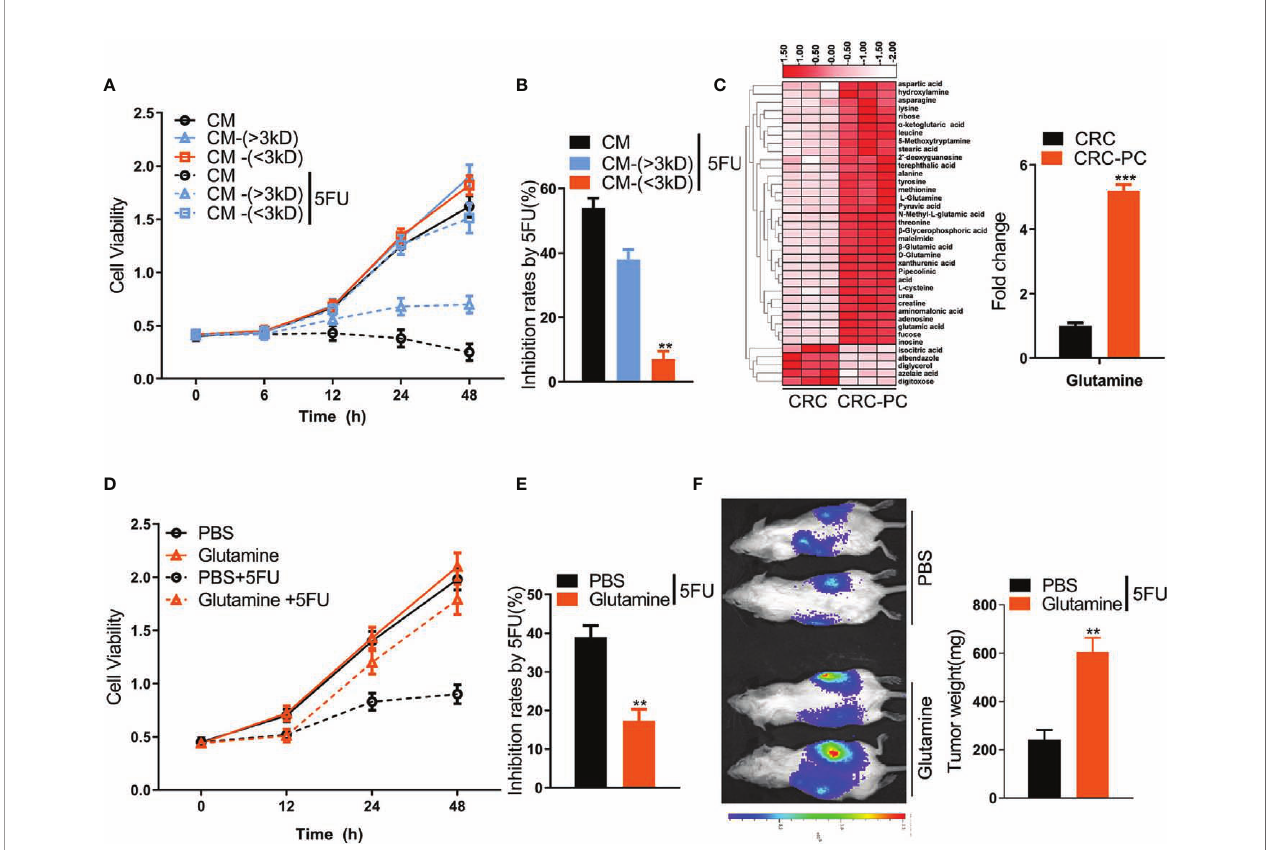
FIGURE 2 | Adipocyte-derived glutamine (Gln) promotes resistance to 5FU chemotherapy in mouse CRC cells. (A) CM was separated into two fractions based on size: CM-(<3 KD) and CM-(>3 KD). The cell viability of CT26 cells treated with CM, CM-(<3 KD) or CM-(>3 KD) plus with/without 5FU (10 m mol/L) was measured. (B) The growth inhibition rates by 5FU were calculated according to (A) (n = 5, ** P < 0.01). (C) Left, heatmap showing differential metabolic pro fi les of fat tissues from the peritoneum of the in situ CRC mode (CRC) (n = 3) and the peritoneal metastasis model (CRC-PC) (n = 3). The color represents the metabolite concentration of each sample calculated by peak area normalization method. Right, fold change of Gln level between the CRC-PC and the CRC group (n = 3, *** P < 0.001). (D) Cell viability of CT26 cells treated with 5FU (10 m mol/L), Gln (2 mM) or Gln (2 mM) plus 5FU (10 m mol/L). (E) Inhibition rates by 5FU according to the data in (D) (n = 5, ** P < 0.01). (F) Gln-induced chemoresistance to 5FU. Left, tumor growth in peritoneal xenografts. Right, tumor weight. The tumors were isolated and weighed on day 17 (n = 5, ** P <